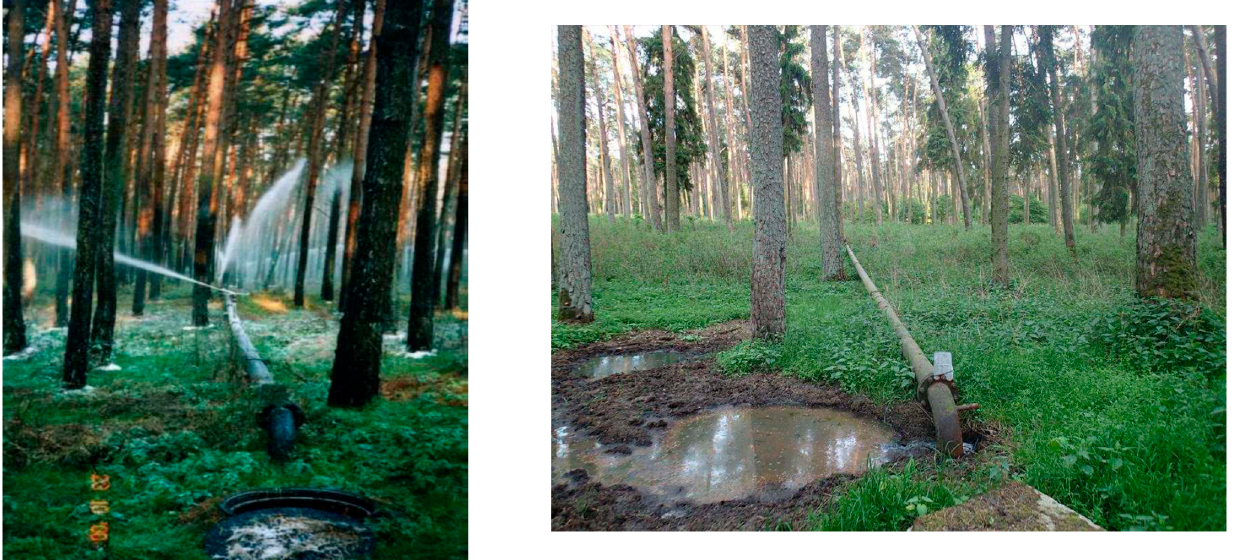
Figure 3. Sprinkling with sewage of stands on the FWTP in 2000 (Photos: Archives of the Forest Management and Geodesy Office–Department in Olsztyn, Poland).